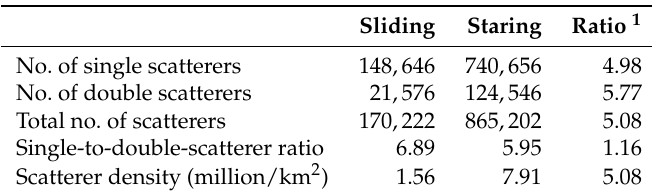
Figure 6. Updated topography (m) of the region in Figure 5b with 12 TerraSAR-X images in the sliding (left column) and staring (right column) spotlight modes, respectively. The upper and lower rows show single and double scatterers, respectively [48]. Table 2. Statistics of the point clouds in Figure